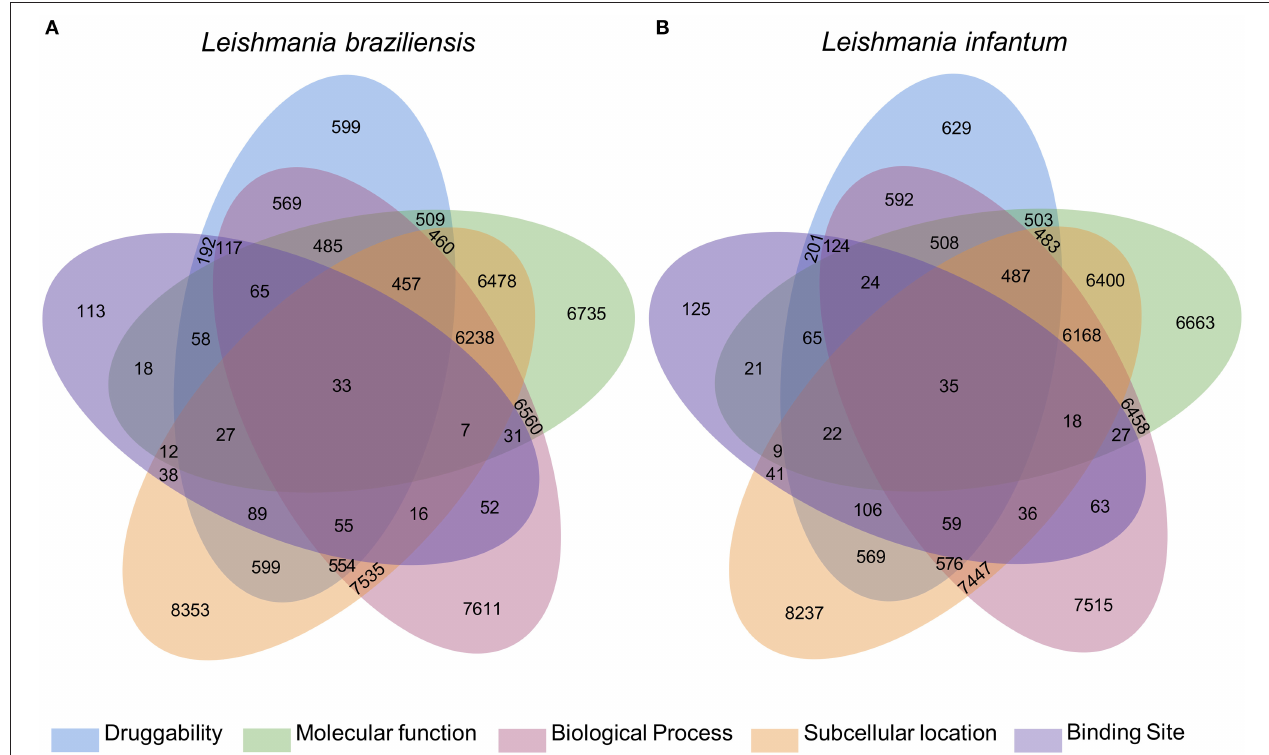
FIGURE 1 | Diagram with results of the multidisciplinary approach to select targeting drugs from Leishmania species proteome. The Venn diagram illustrates the integration of the results found for the selection of druggable proteins based on structural, functional, and subcellular location evidence. From these results, it is possible to find 119 and 116 proteins of L. braziliensis (A) and L. infantum (B) , respectively, with evidence of potential drug targets for having similarity with known targets in at least 4 methodologies used, 2 of which are based on the formation and composition of the target binding site (druggability and binding